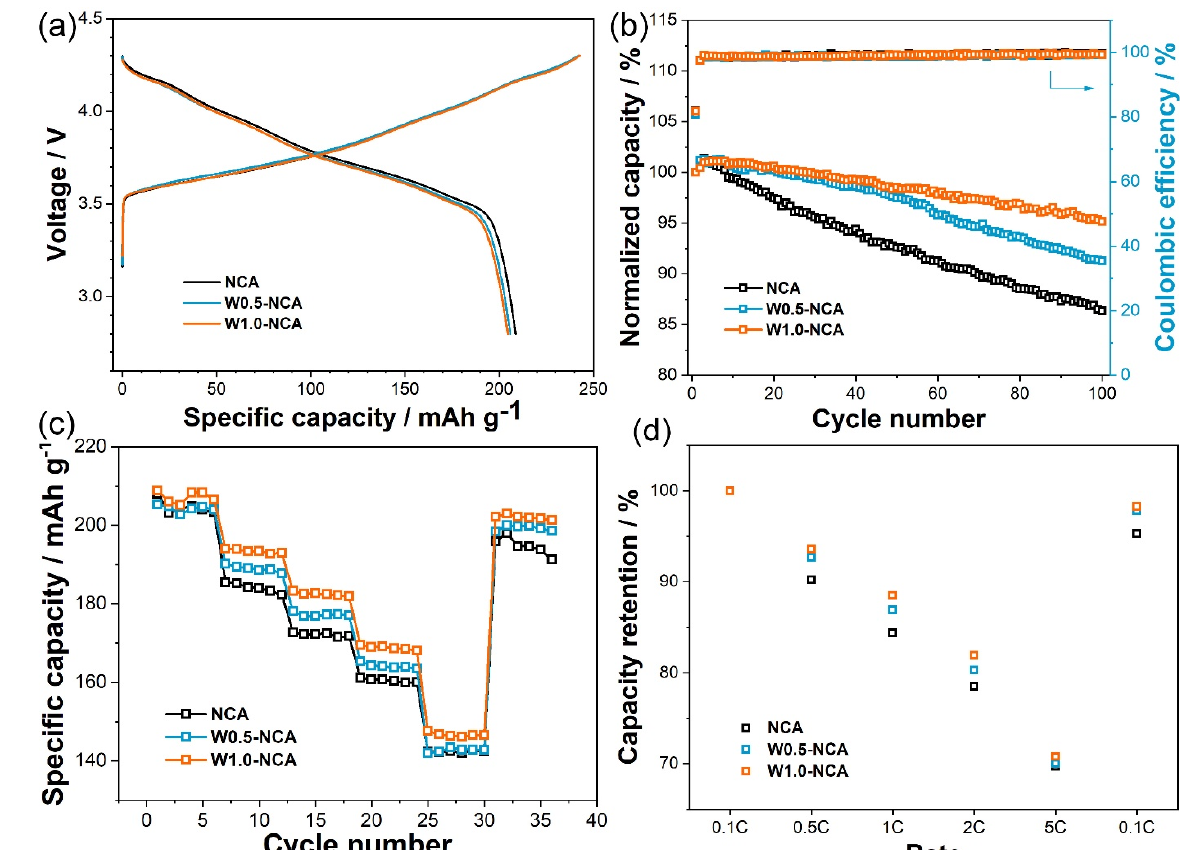
Figure 5. ( a ) Initial charge/discharge profiles at 0.1 C, ( b ) Cycling performance and coulombic efficiency at 1 C, ( c ) Rate capability of 0.1–5.0 C, and ( d ) Relative discharge capacity retention as a function of C-rate for NCA, W0.5-NCA, and W1.0-NCA cathodes between 2.8–4.3 V.